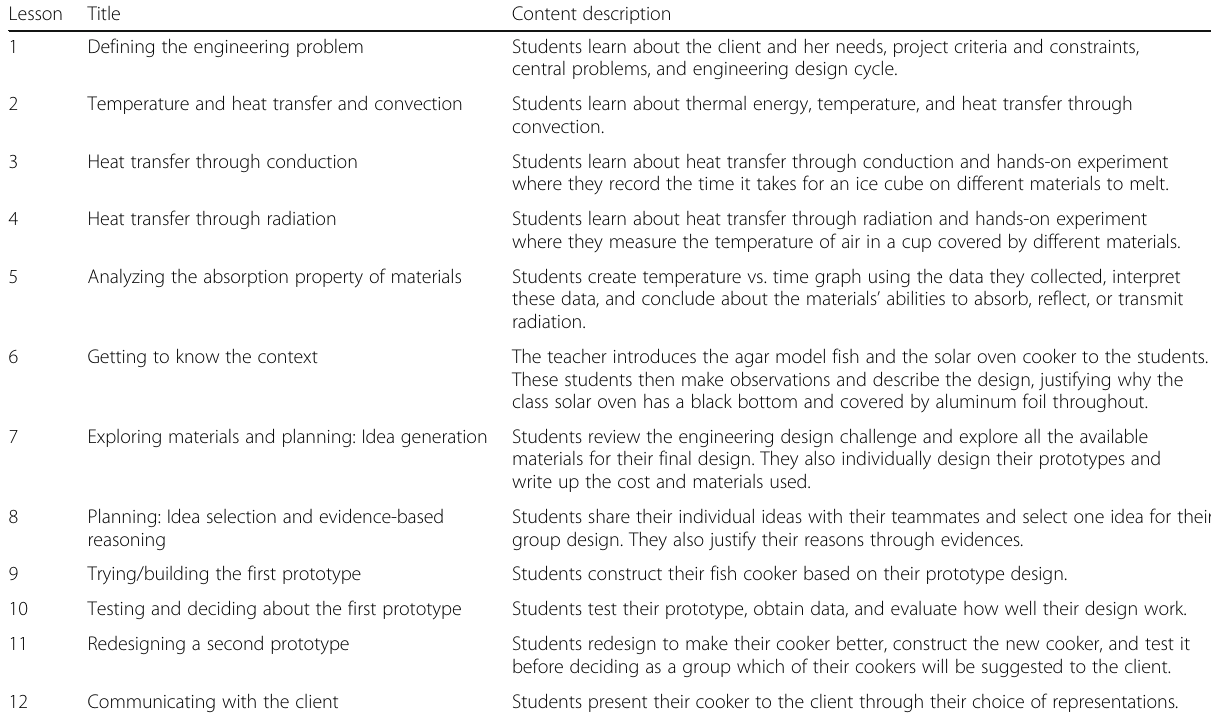
Table 1 Lesson summary of the Ecuadorian fishermen